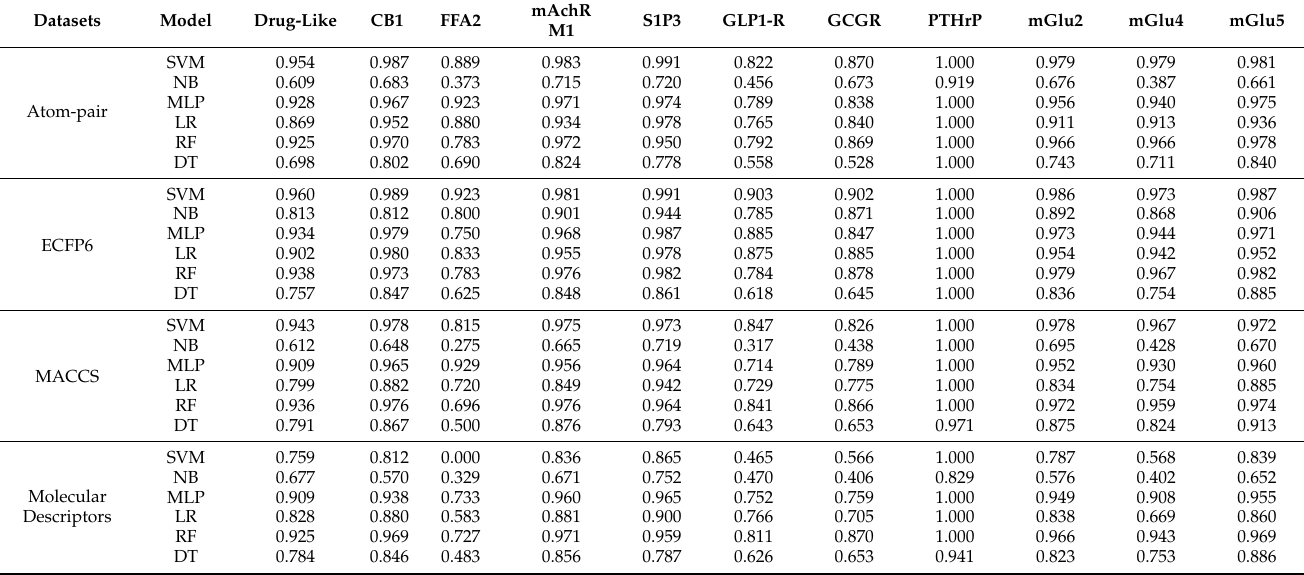
Table 6. The f 1 -score of the Test Set on Each Dataset with One Feature Type on Each GPCR Class.